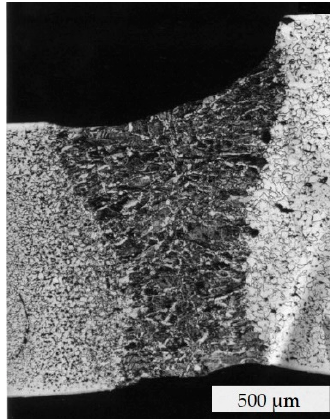
Figure 4. Micrograph of the TWB2 specimen.